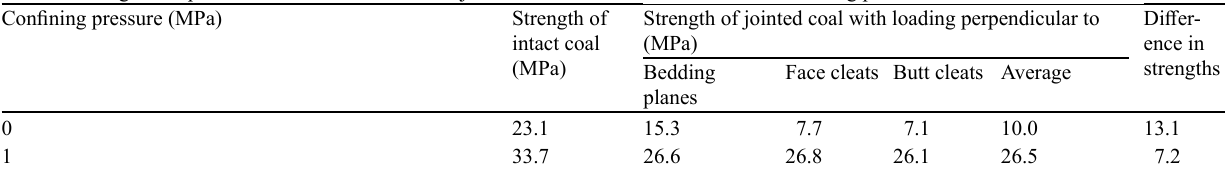
Note: Difference in strengths refers to the strength difference between intact and jointed coal. The numerical results of coal without confining pressure are cited from Wang et al. (2018)